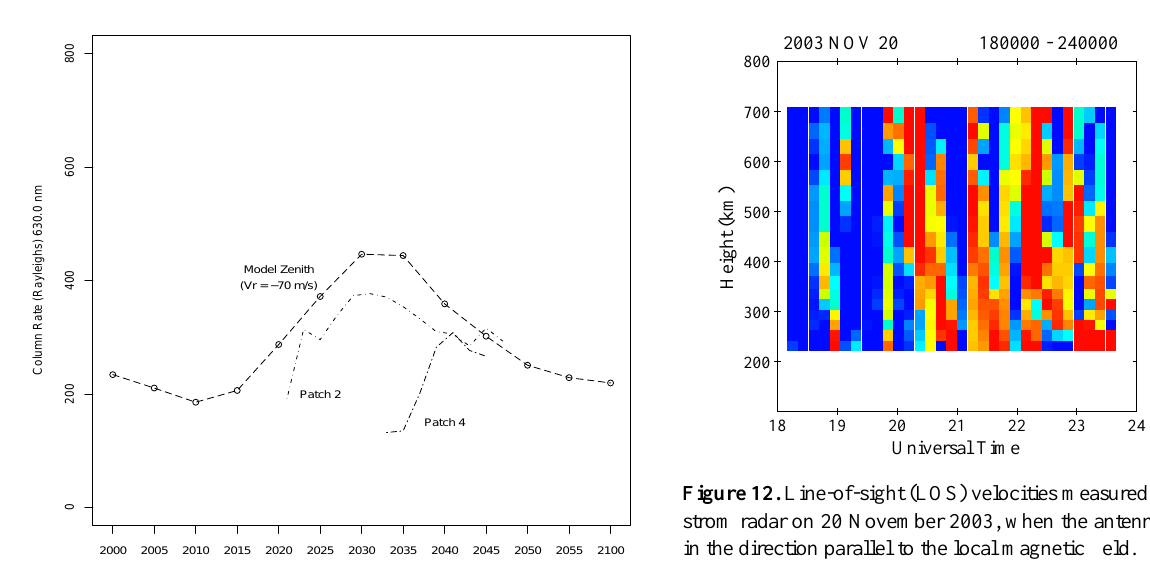
Figure 10. Distance–time plots of Doppler velocity (defined positive toward the radar) observed by the Kapuskasing radar. Note the channel of large negative values ( ∼ 1500ms − 1 ) seen in the panel of 19:42–19:43:32UT